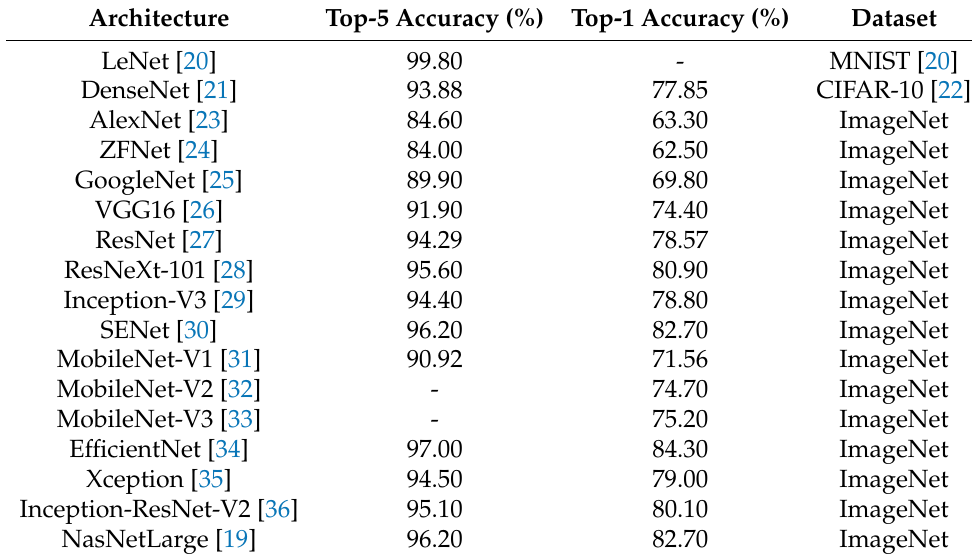
Table 1. Image classification architectures’ accuracy